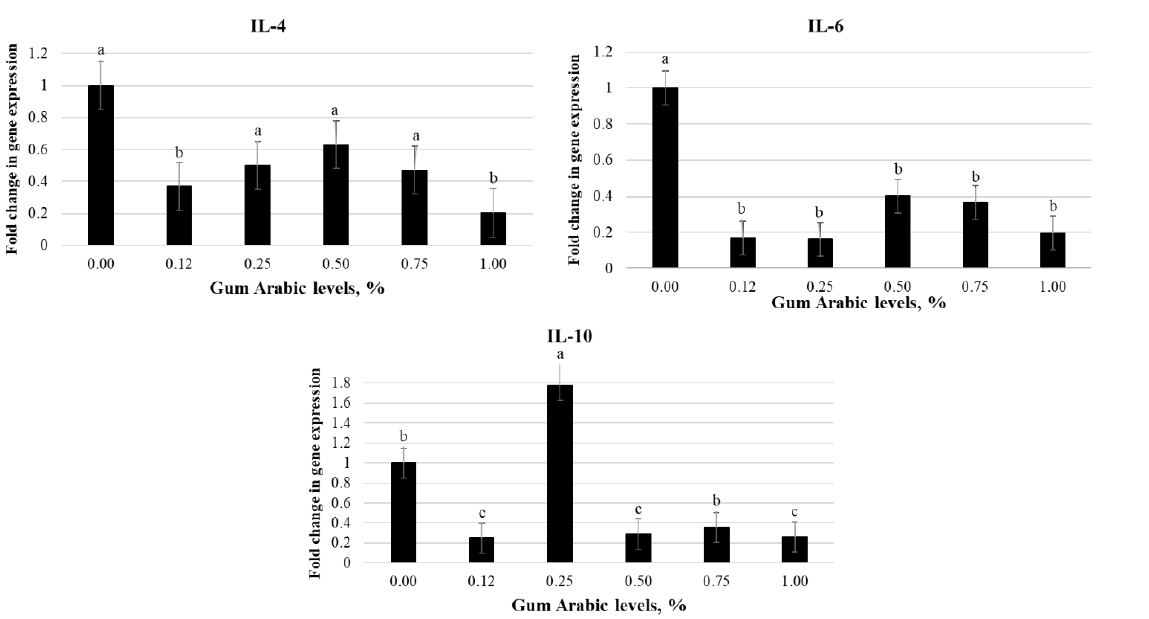
Figure 1. Effect of gum Arabic (GA) on immune-related gene expression of male broiler chickens on day 10 of age. IL-4 = Interleukin 4 ( p -value: GA = 0.020; L = 0.002; Q = 0.662). IL-6 = Interleukin 6 ( p -value: GA = 0.001; L = 0.001; Q = 0.008). IL-10 = Interleukin 10 ( p -value: GA = 0.001; L = 0.051; Q = 0.321).